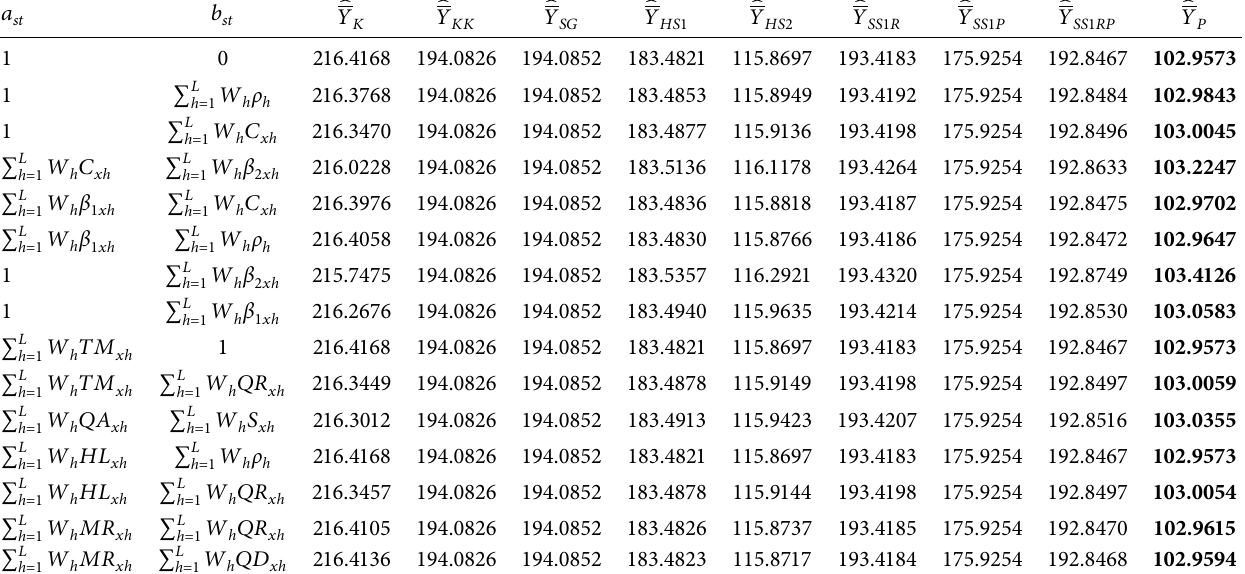
Table 3: Minimum MSEs of different estimators based on real data.